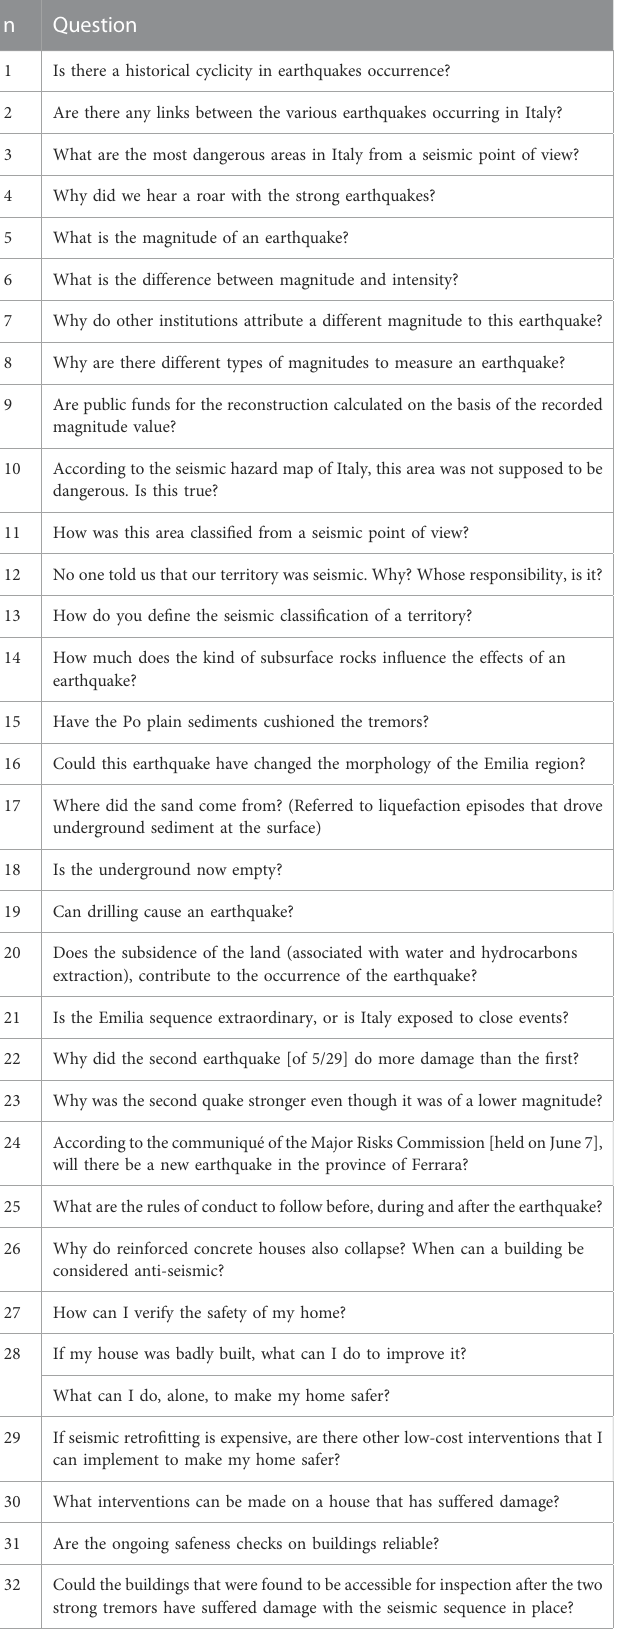
TABLE 3 List of common questions raised during the public meetings organized during and after the 2012 Emilia seismic